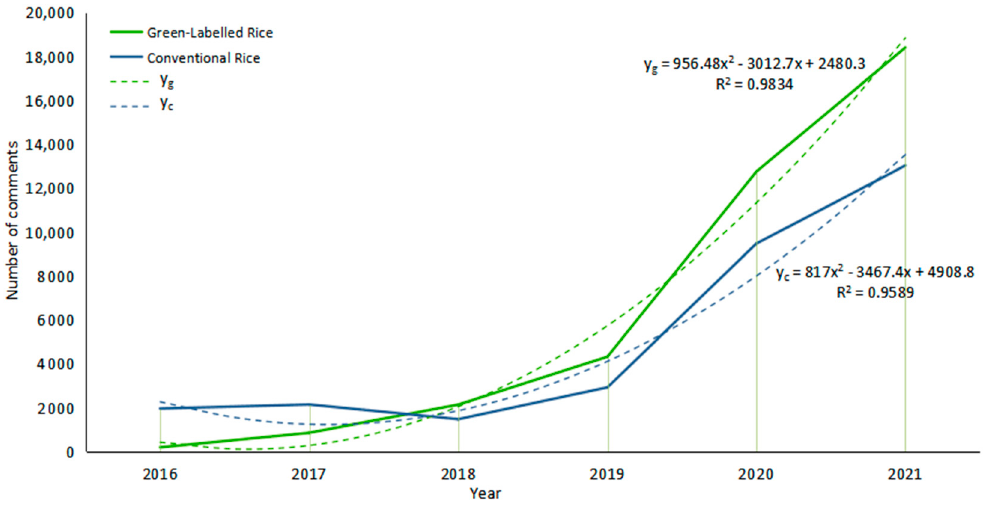
Figure 3. Level of attention on green-labelled rice and conventional rice.